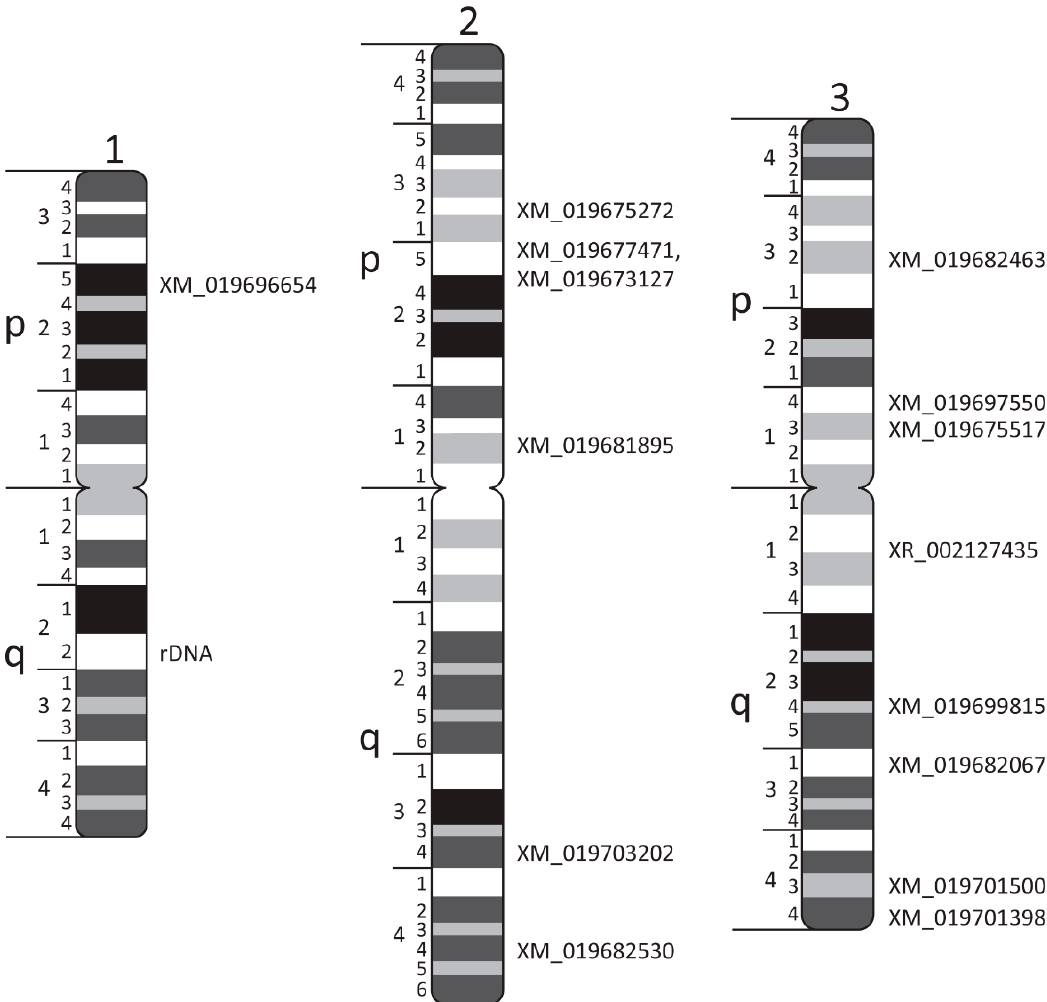
Figure 3. The locations of 15 DNA probes in the chromosome idiograms of Ae. albopictus . Chromosomes and chromosome arms are indicated by the numbers 1, 2, and 3 and the letters p and q, respectively. Chromosome divisions and subdivisions are shown on the left side of the idiograms. Transcripts are indicated on the right side of the idiograms; rDNA stands for ribosomal locus.